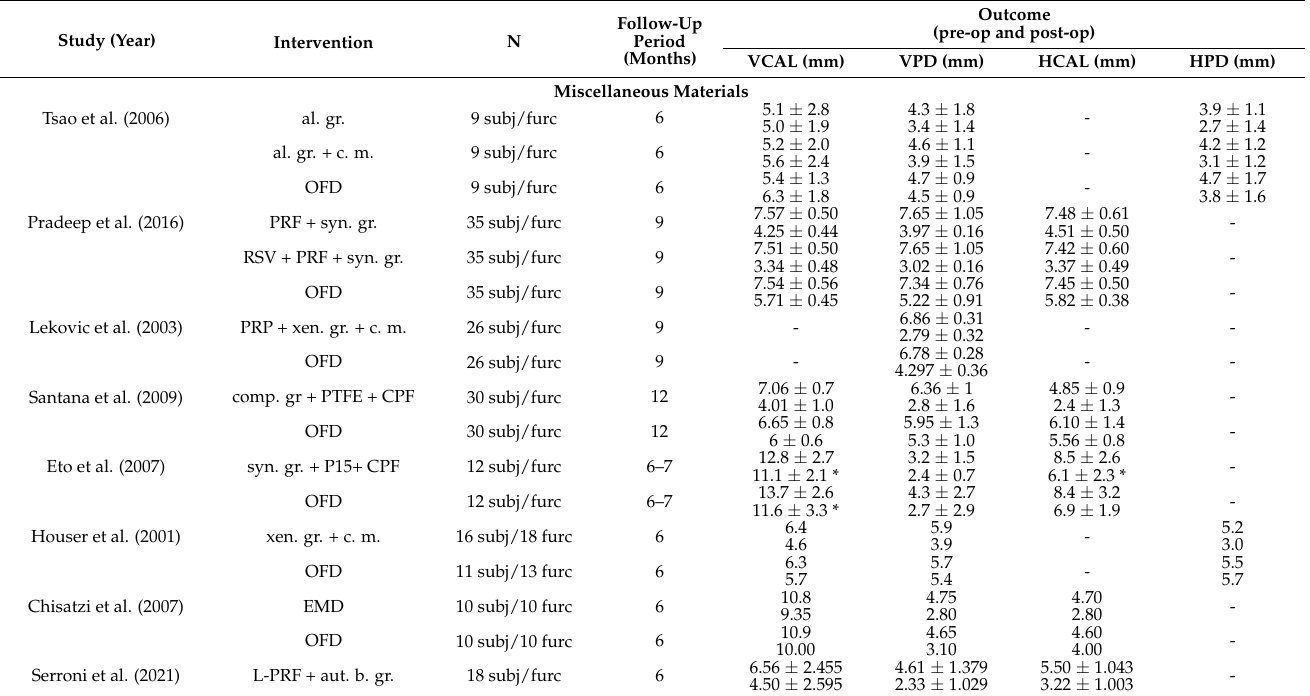
Table 6. Results reported at baseline and at follow-up in papers where miscellaneous materials were